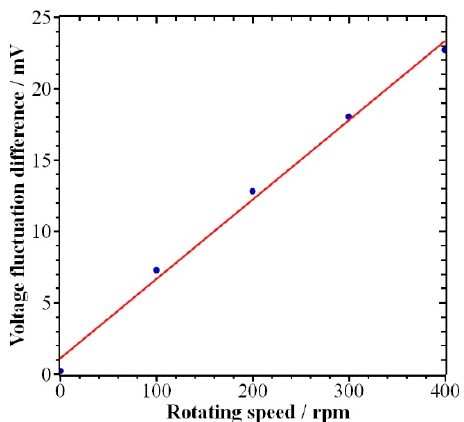
Figure 5. Detection of voltage changes at different speeds.